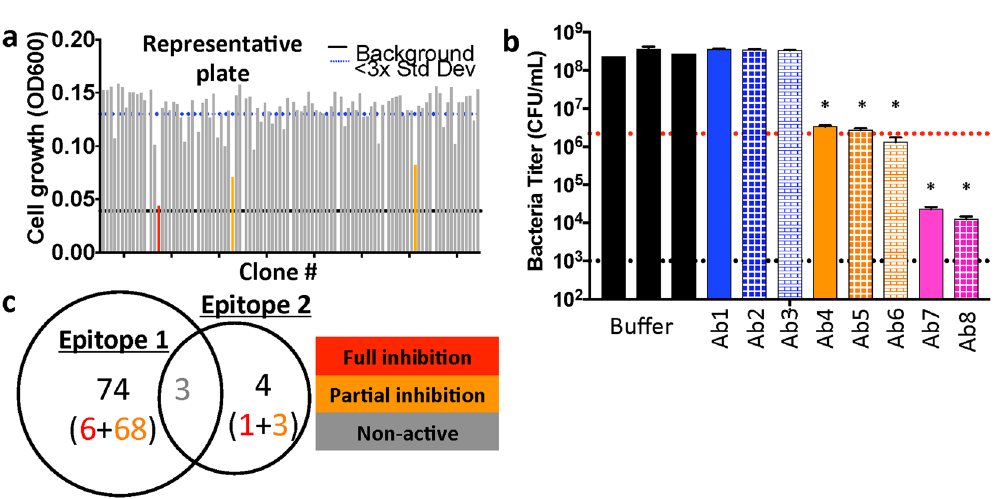
Figure 5. Functional and biochemical properties of rare panel of inhibitory anti-BamA mAbs. ( a ) OD600 values for Δ waaD strain after treatment with one representative plate of anti-BamA mAbs at 10 μ g/mL for 4 hours. Analysis reveals the presence of rare partially inhibitory (orange lines) or fully inhibitory (red line) anti- BamA mAbs. Black line indicates lower limit of detection and dashed blue line indicates 3 standard deviations below buffer control. ( b ) CFUs were quantified for the Δ waaD strain at 0 hrs and 4 hrs after treatment with a subset of anti-BamA mAbs or buffer at 10 μ g/mL ( * p < 0.001 compared to buffer controls). Red dashed line represents CFUs measured at 0 hr and black dashed line represents lower limit of detection. Experiments were performed in biological triplicate. ( c ) Venn diagram of epitope-binning results on panel of anti-BamA mAbs reveals two epitopes that partially overlap. Bin 1 contains 6 full inhibitors (red) and 68 partial inhibitors (orange), whereas fewer mAbs (1 full and 3 partial inhibitors) occupy bin 2. Interestingly, non-inhibitory clones (grey) can block binding of mAbs in both epitope